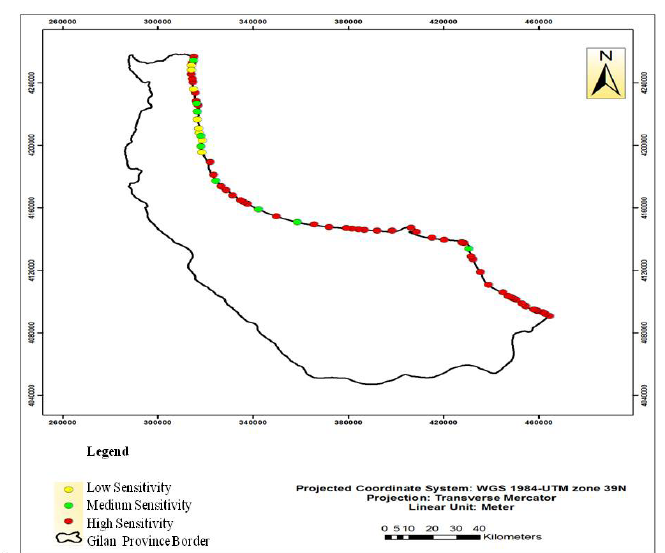
Figure 1. Physical classification of the coastal strip